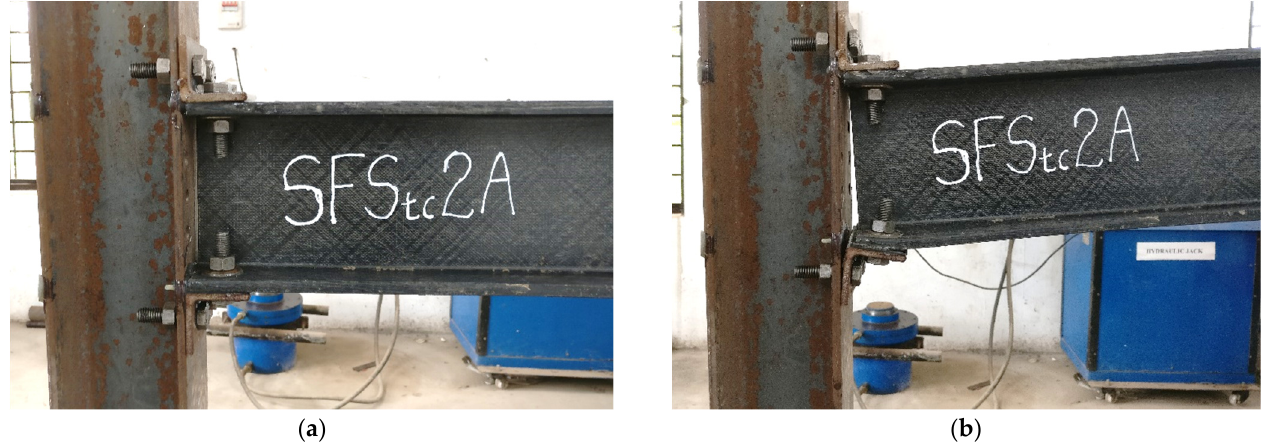
Figure 14. Shear-out failure in specimen SFSct2: ( a ) Undeformed joint; ( b ) Deformed joint.